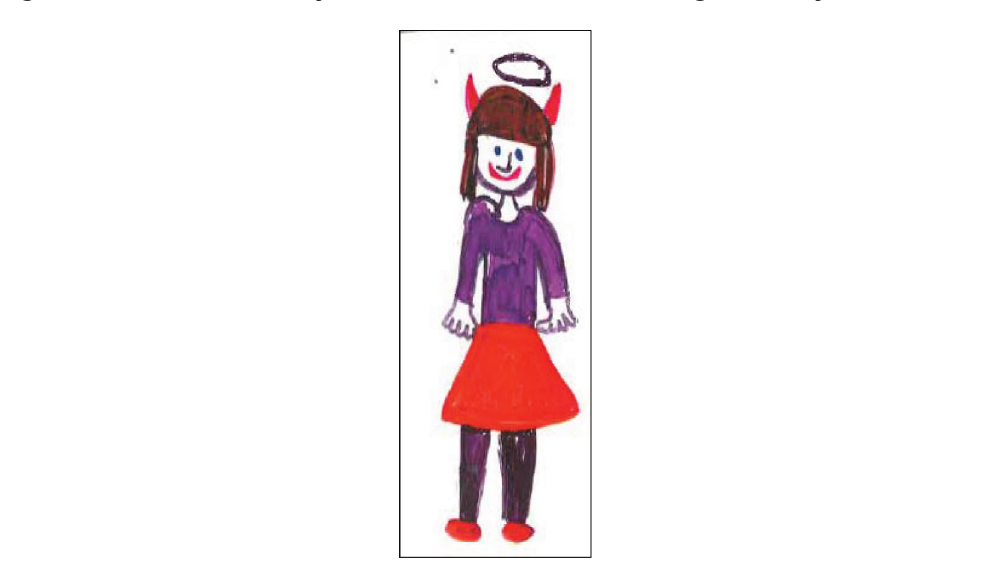
Figure 1: ‘I wonder what my new carer will be like?’ An image from My Name is Joe